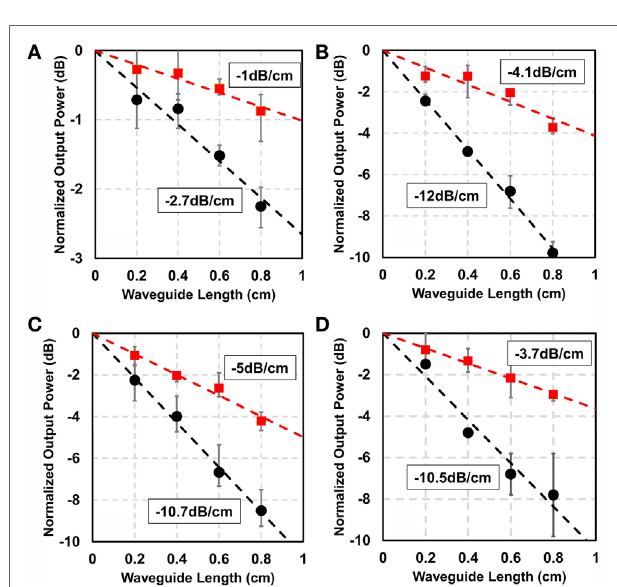
FigUre 5 | normalized optical output power vs. waveguide length after dry etching (black circle) and wet etching (red square) for (a) strip waveguide with no slot and slot waveguides with slot widths of (B) 100 nm, (c) 150 nm, and (D) 200 nm .